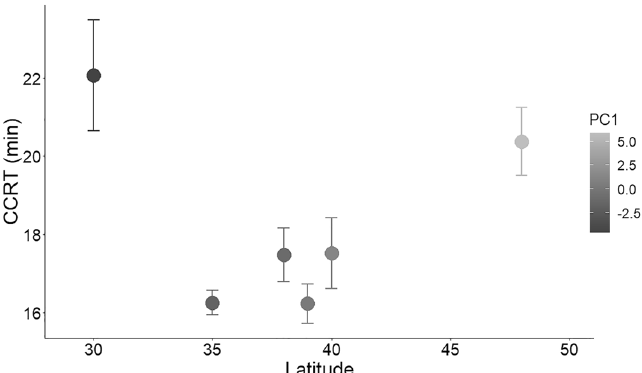
Figure 5. Relationship between latitude (as a proxy of photoperiod) and chill coma recovery time (CCRT) of Ceratitis capitata adults from six populations. The effects of latitudinally varying temperatures and summer precipitation (PC1) on C. capitata populations are illustrated in grey scale (lighter colors represents the colder populations with wet summers and the darker ones the warmer populations with dry summer). Error bars represent standard error of the mean (Mean ± SE).